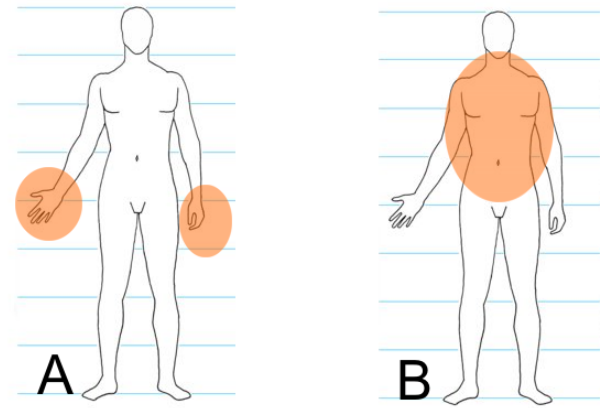
Figure 2. Areas where a knife may appear near offender ( A ) and defender ( B )